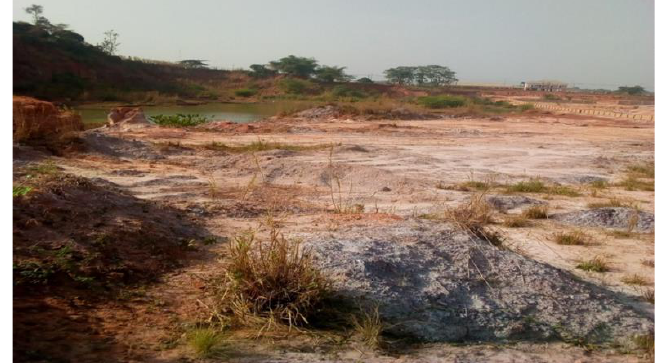
Figure 2: Evidence of On-site Degradation of the Study Site